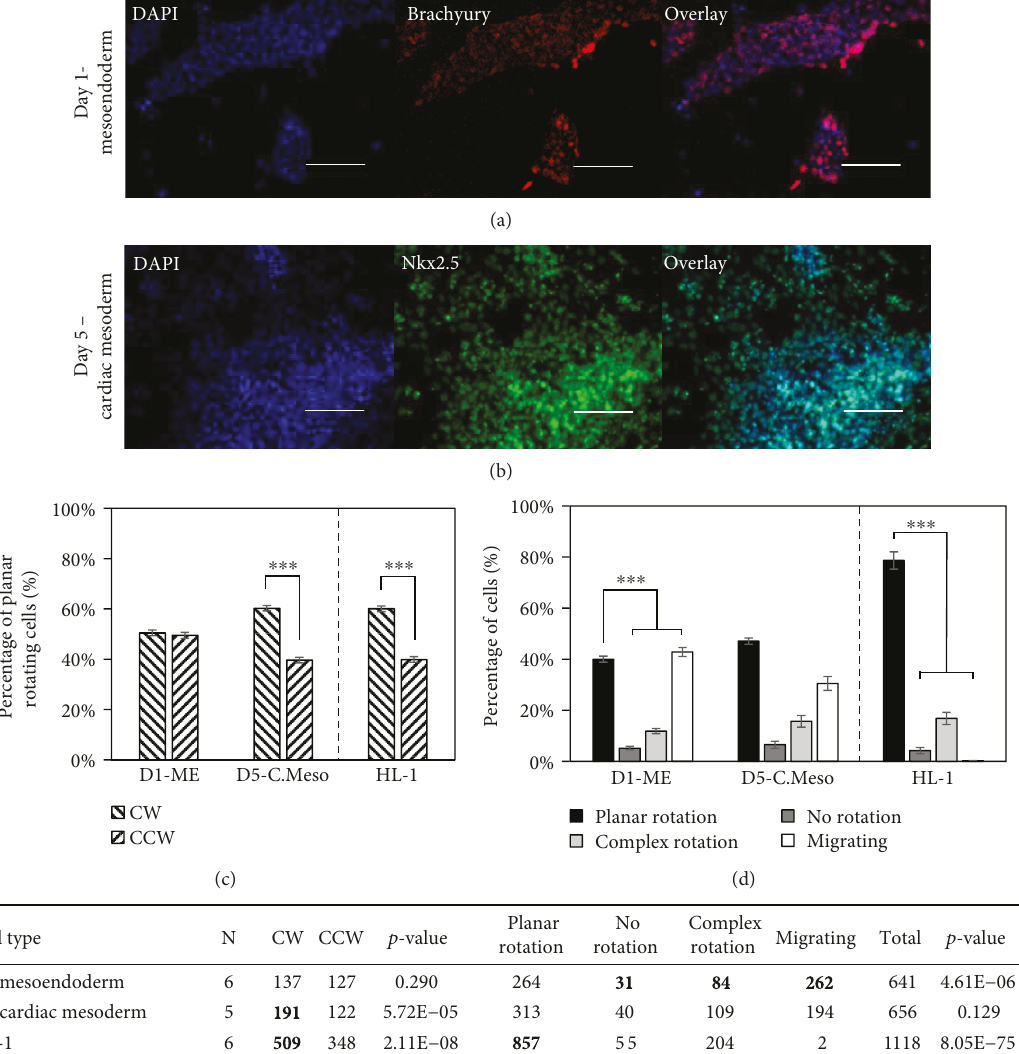
Figure 2: Cardiac mesoderm cells display dominant CW biased rotation similar to a mouse cardiac cell line, HL-1. (a) Day 1 mesoendoderm cells expressing brachyury. (b) Day 5 cardiac mesoderm cells expressing Nkx2.5 (c) Mesoendoderm (D1-ME) shows no rotational bias, and cardiac mesoderm (D5-C.Meso) displays a CW bias along with the mouse cardiac muscle cell line, HL-1. (d) Mesoendoderm has more migrating, no-rotation, and complex rotating cells than planar rotating cells. Cardiac mesoderm shows no di ff erence between the two sets of groups while HL-1 cells are primarily planar rotating. (e) Quantitative data showing the number of cells in each category along with the number of replicate experiments ( N ). The p values indicate comparisons between CW and CCW and between planar rotation and the other three categories. Scale bars: 100 μ m; ∗∗∗ p < 0 001